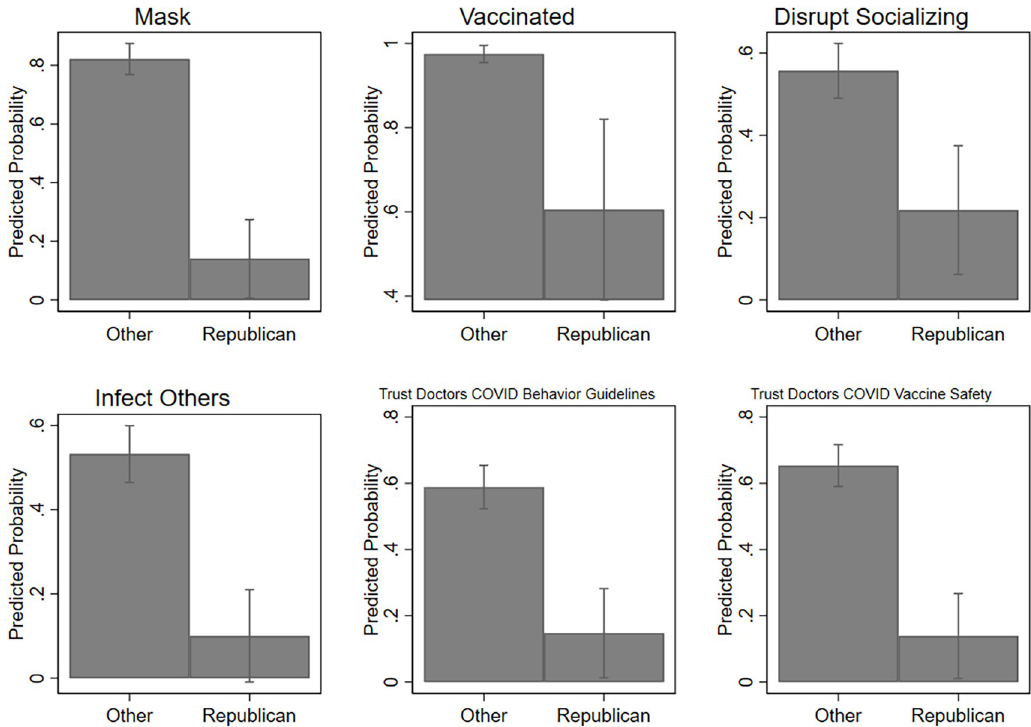
Fig 3. Political identity and COVID-19 safety behaviors. Fig 3 shows the predicted probabilities (calculated based on Model 3 in Tables 3 and 4) of a variety of COVID-19 behaviors and beliefs among Republicans versus those with other political affiliations (including Democrat, Independent and other), while holding age, gender, high risk status and collectivism constant at their means. The figures demonstrate that Republican are significantly less likely than other groups to consistently wear as mask, to be vaccinated, to have allowed the pandemic to disrupt their socializing, to be concerned about infecting others, and to trust doctors for behavioral guidance and vaccine safety